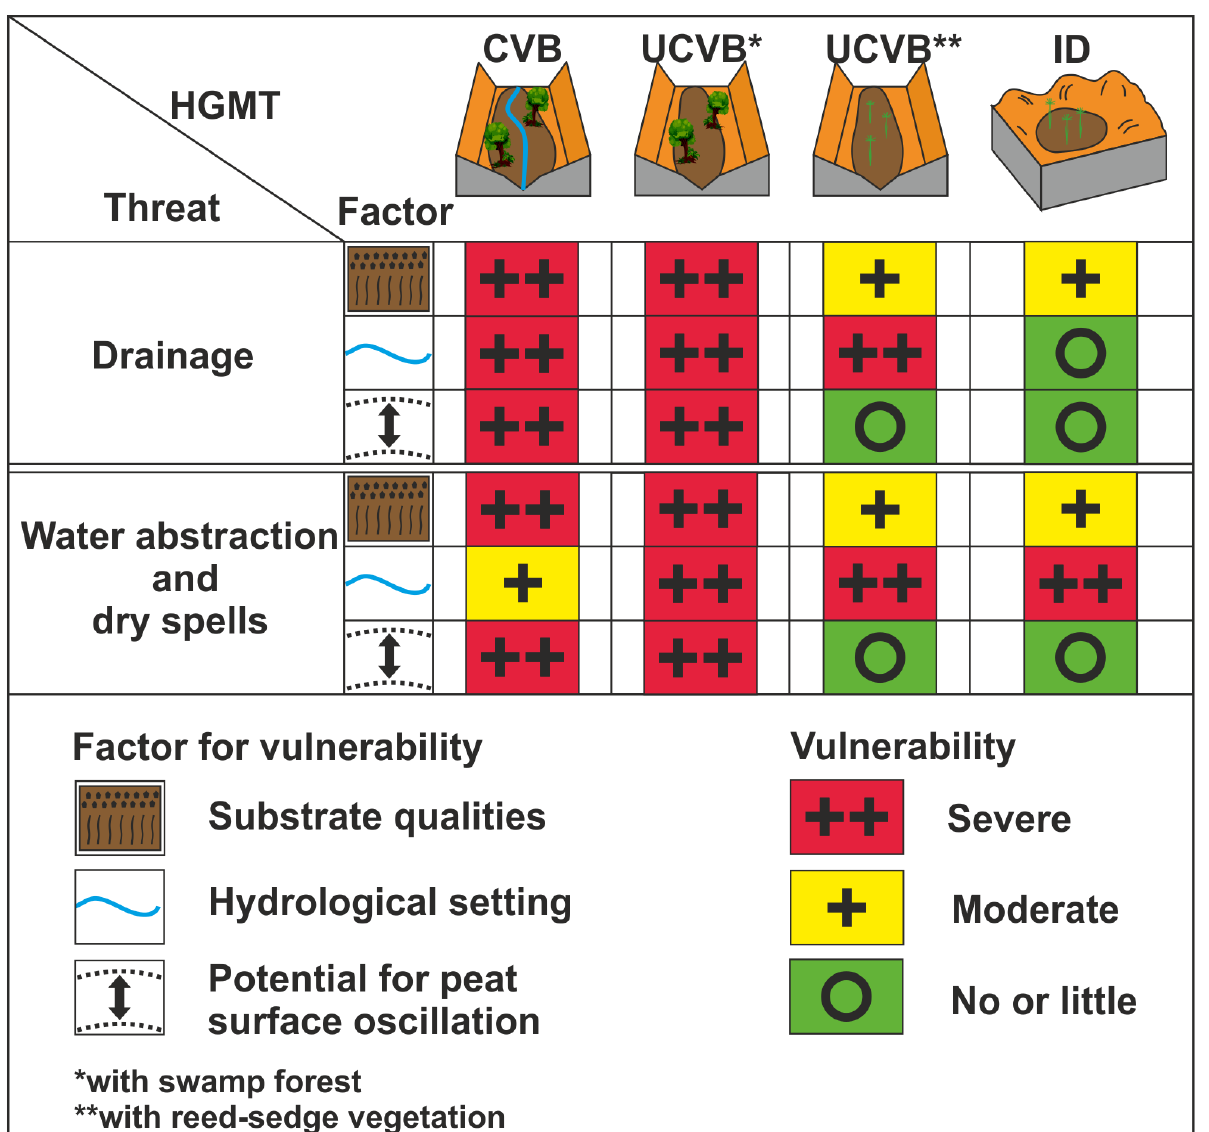
Figure 11. Summary overview of the hydrological vulnerability of different